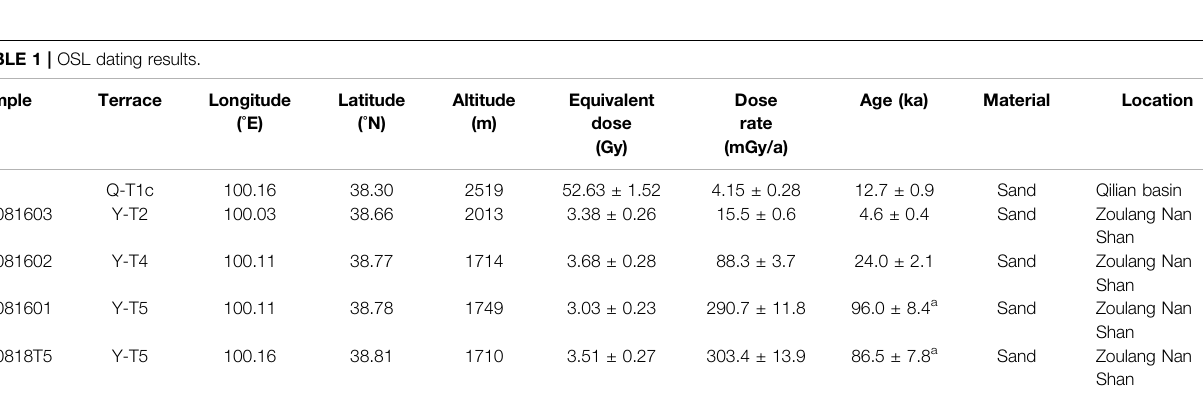
TABLE 1 | OSL dating results. Sample